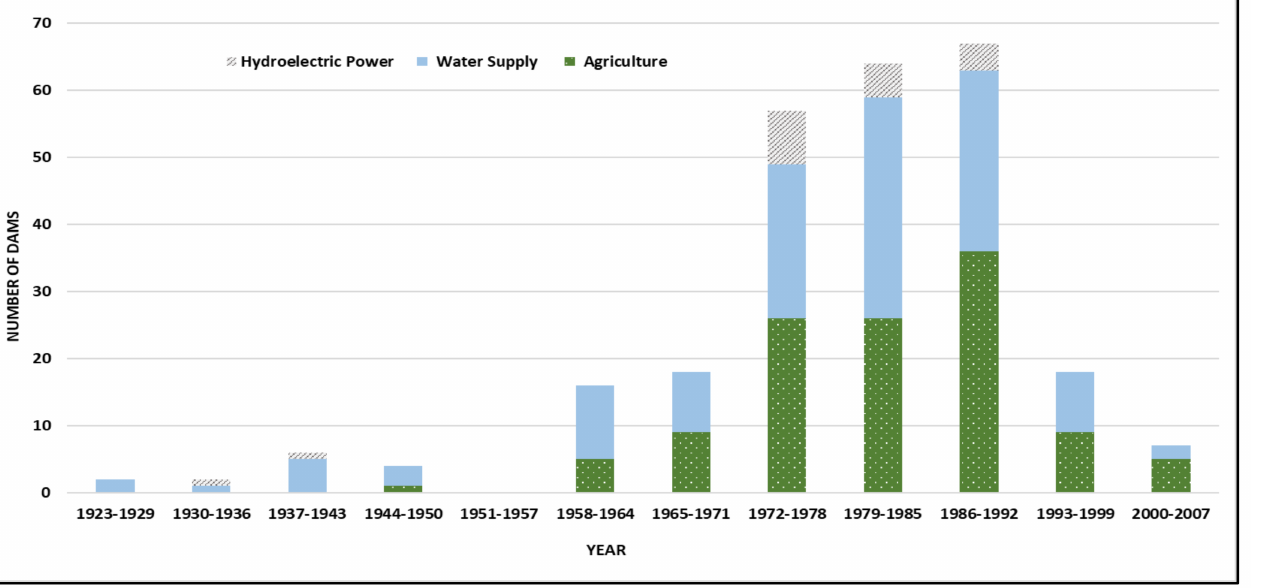
Figure 6. Distribution of completed hydroelectric power, agriculture, and water supply dams 1923–2007